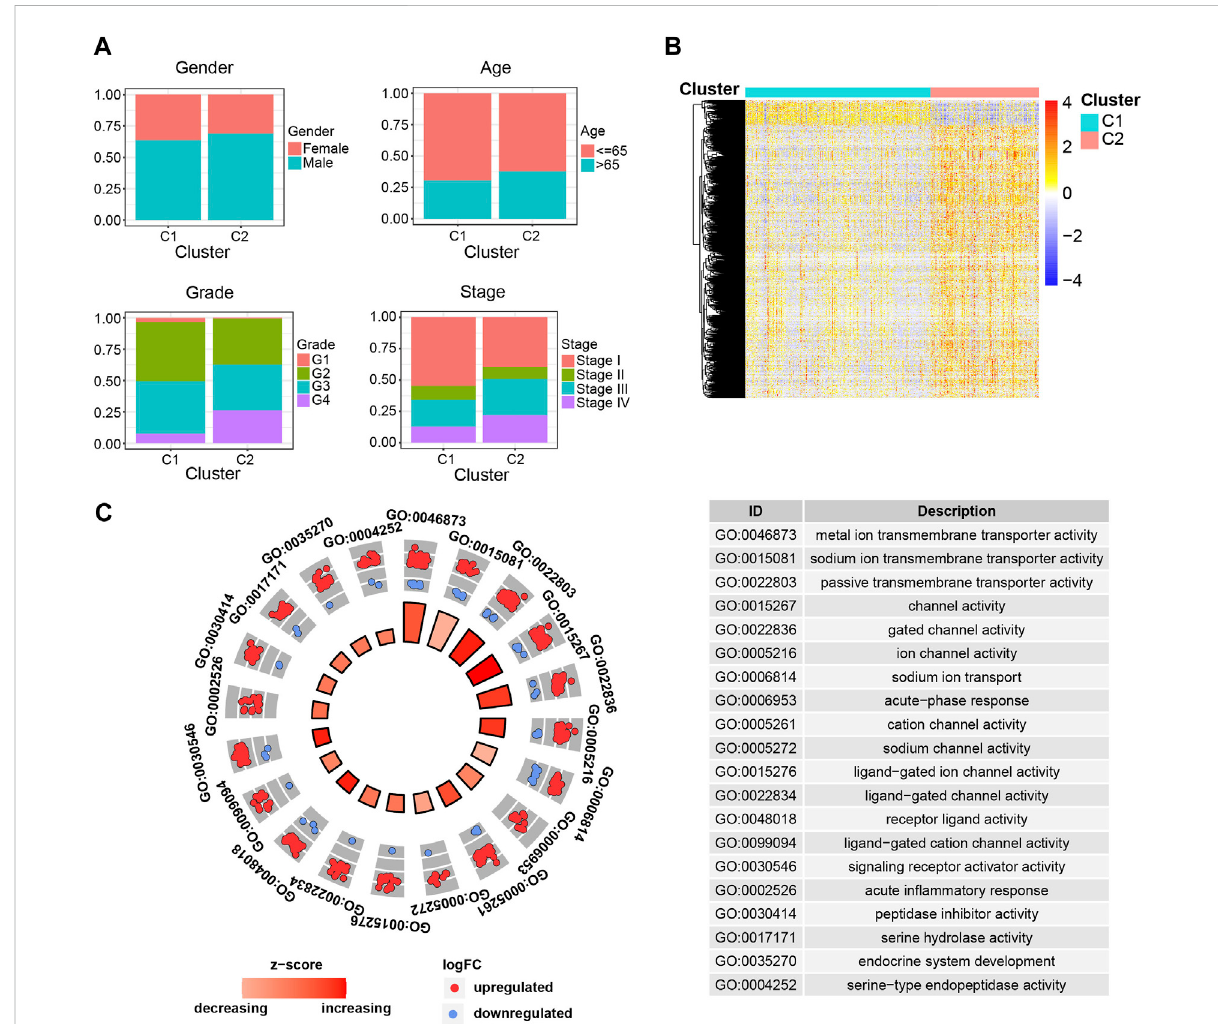
FIGURE 2 Clinical and molecular differences between the C1 and C2 subgroups. (A) Comparison of the clinical characteristics between the indicated subgroups of ccRCC. (B) Heatmap shows the differentially expressed genes (DEGs) between the indicated subgroups of ccRCC. (C) Functional enrichment of the